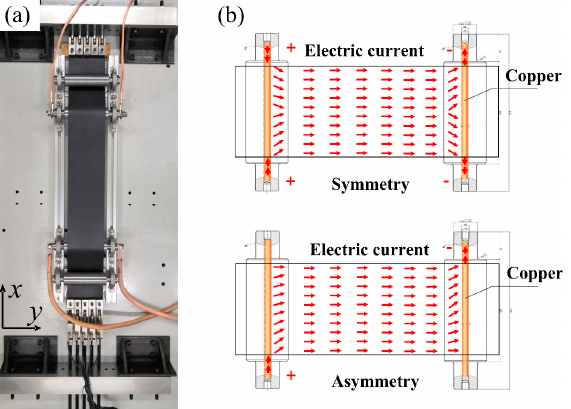
Figure 1. The uneven field measurement device: ( a ) the tensile device with wrap angle; and ( b ) electron flow diagram.